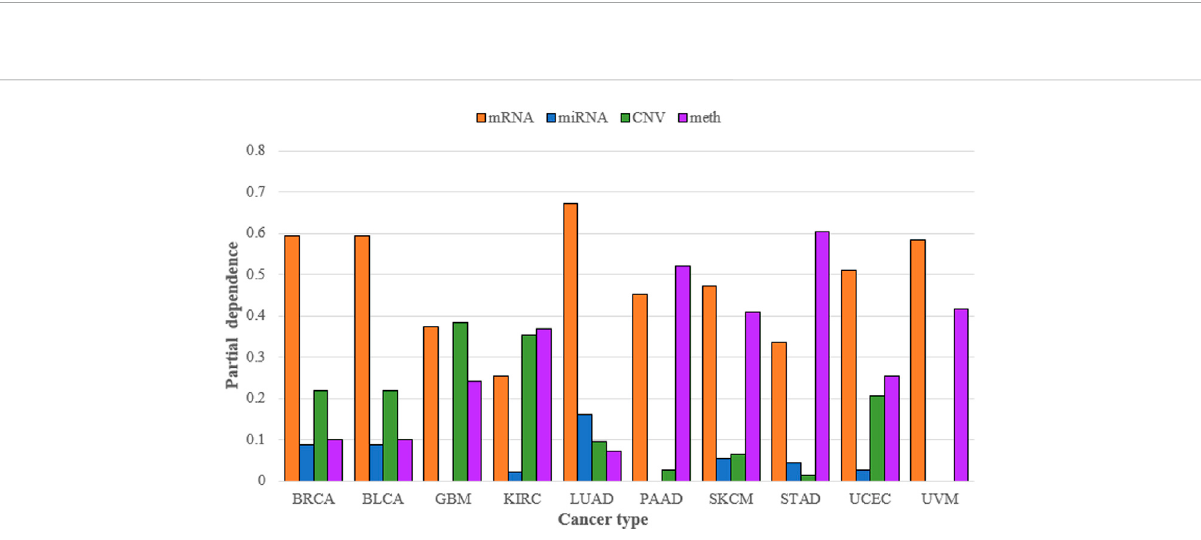
FIGURE 3 Contribution of mRNA, miRNA, CNV, and DNA methylation to the subtyping results of SADLN on ten cancer datasets.